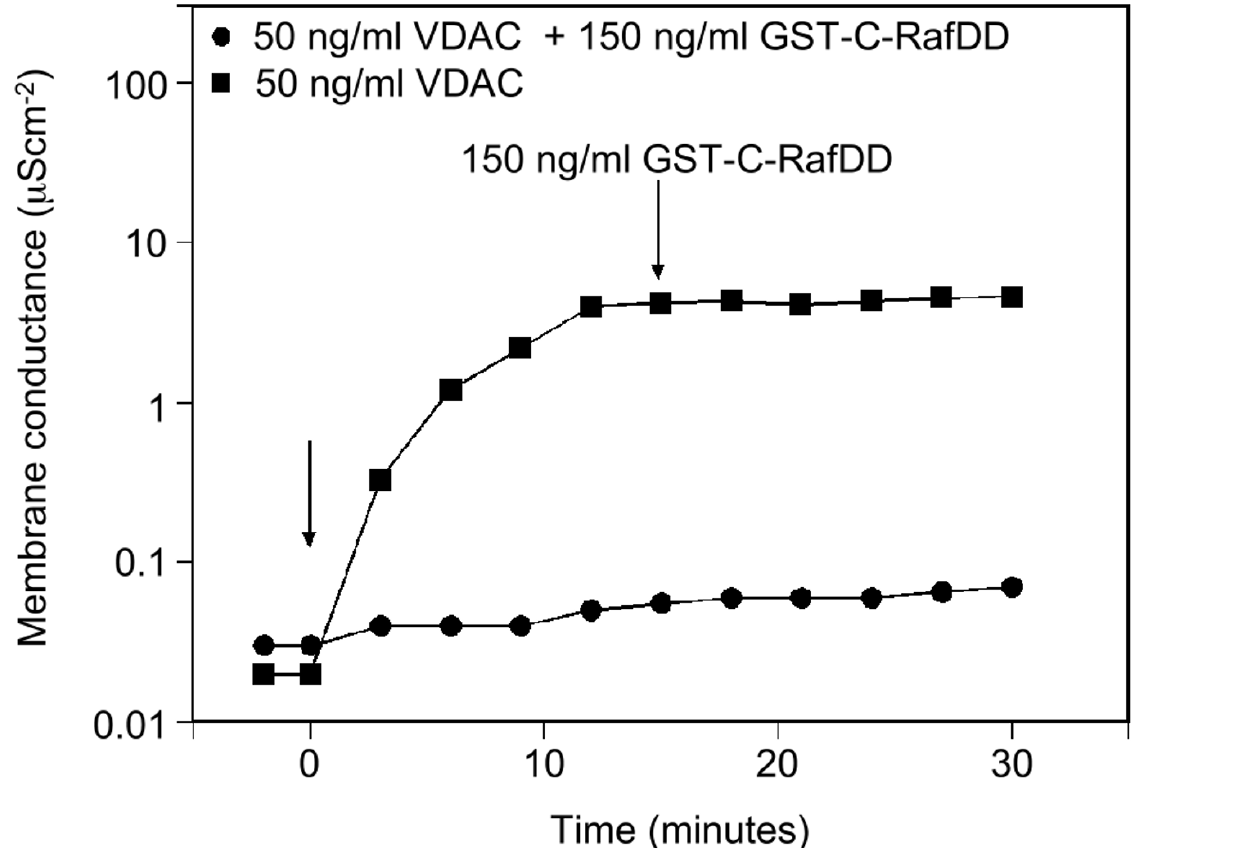
Figure 8 C-Raf blocks VDAC reconstitution into membranes. Membrane conductance as a function of time after the addition of 50 ng/ml VDAC (full squares) and 50 ng/ml VDAC pre-incubated with 150 ng/ml GST-C-RafDD (full points) to DiphPC membranes (left-hand side arrow). The aqueous phase contained 300 mM KCl supplemented with kinase buffer. 15 minutes after addition of VDAC, when the conductance was stationary 150 ng/ml GST-C-RafDD was added to both sides of the membrane (full squares, right-hand side arrow). The temperature was 20 ° C and the applied voltage was 20 mV. Note that the membrane con- ductance increase was inhibited when VDAC was preincubated with GST-C-RafDD (full squares), while this protein had no influence on already existing channels (full